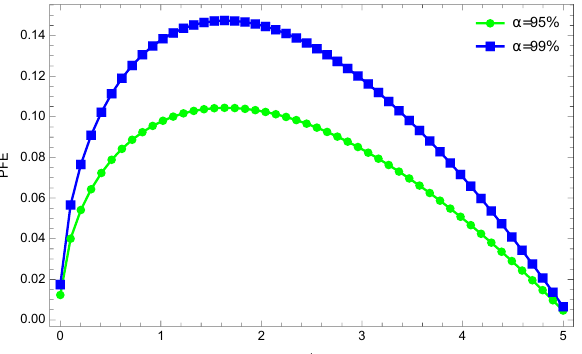
Figure 2. PFE profile of the swap for different confidence